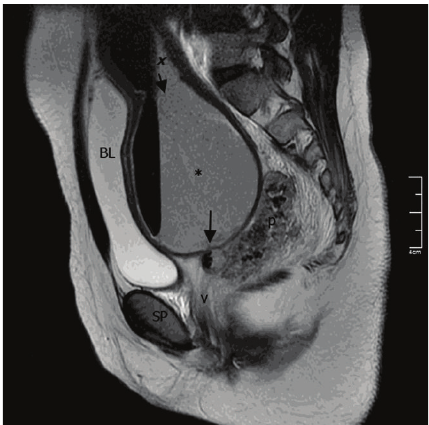
Figure 1: MR imaging demonstrating pus within a distended vagina, endometrial and endocervical canal, and posterior vaginal extraperitoneal leakage (p). A complete mid-transverse vaginal septumwasconfirmedsurgically.SagittalT2-weightedfastspinecho (FSE) image shows distention of the endometrial ( 𝑥 ), endocervical (shortarrow),andvaginal( ∗ )canalsbylow-signal-intensitymaterial with air-fluid level representing pus. Long arrow is pointing at a fistula tract (a collection) between the vagina and rectum. The level of the obstruction lies above the symphysis pubis